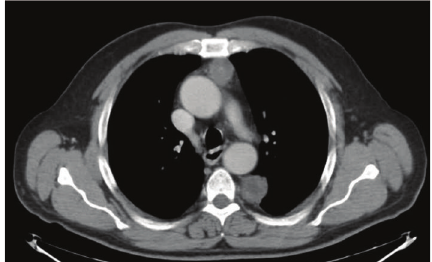
Figure 3: Computerized tomography (CT) scan showing a left posterior mediastinal schwannoma associated with an anterior parathyroid